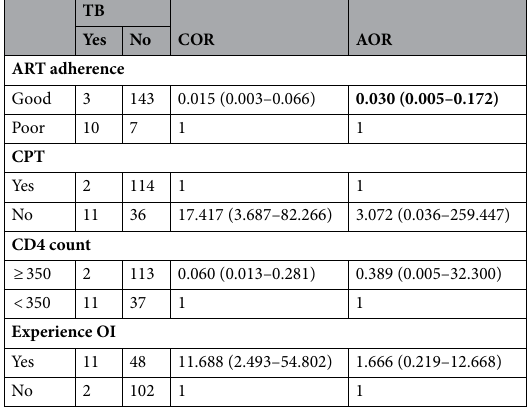
Table 5. Bivariable and Multivariable logistic analysis on factors associated with TB among TB preventive therapy users in PLWHIV Dessie city administrative 2021. Significant values are in